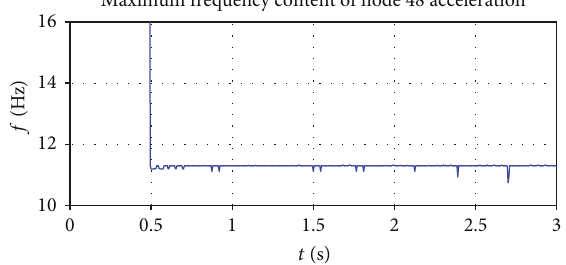
Figure 26: D3, decay test CWT, acceleration in the excitation node.